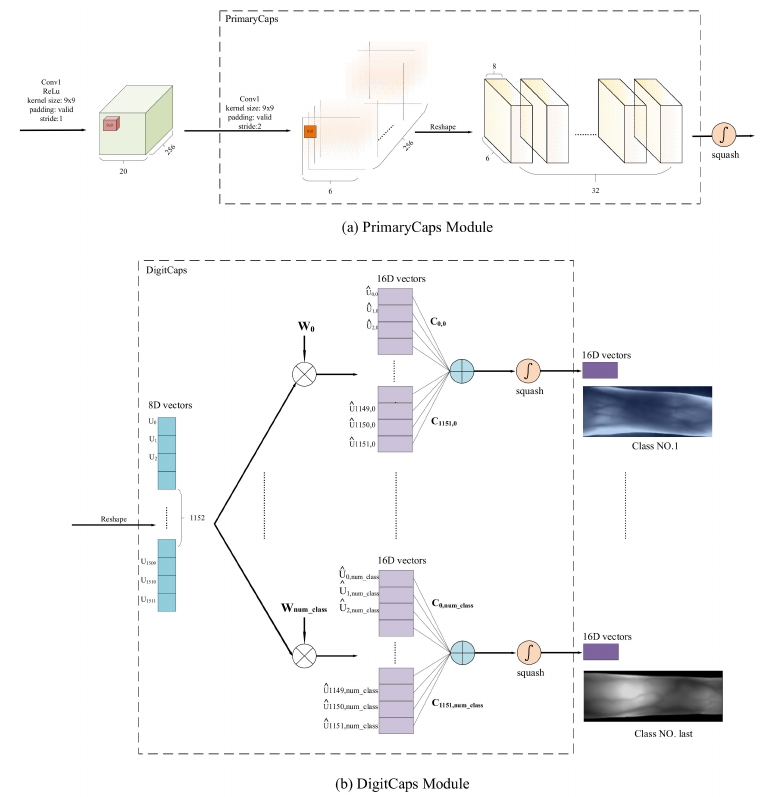
Figure 5. The third part of ViT-Cap model